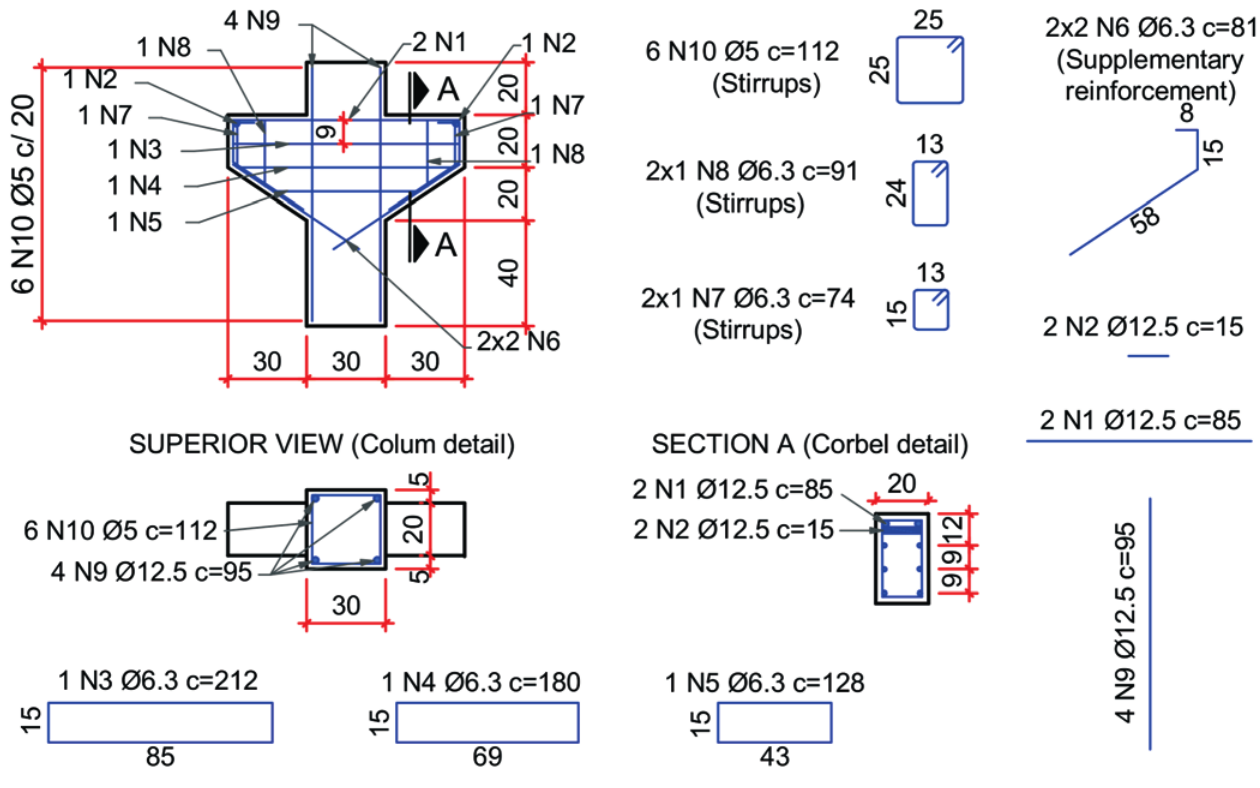
Reinforcement detailing of model with monolithic corbel (P1)